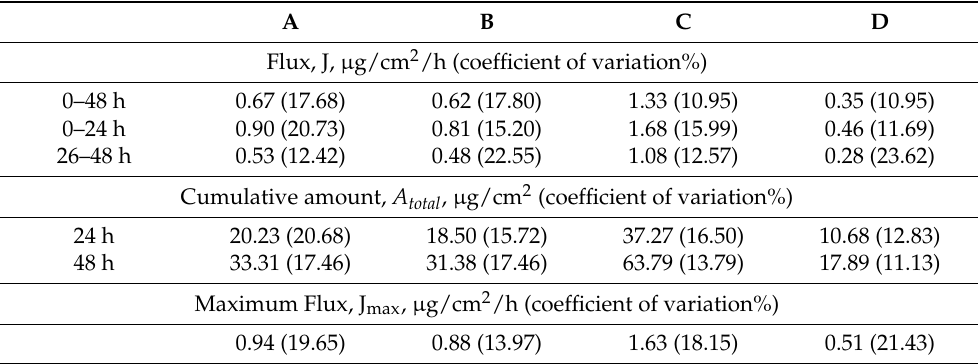
Table 2. A total , J (for long timeframes) and J max expressed as mean values and coefficients of variations ( n = 12) for different timeframes (A—clotrimazole 10 mg/g cream; B—Canesten Antifungal